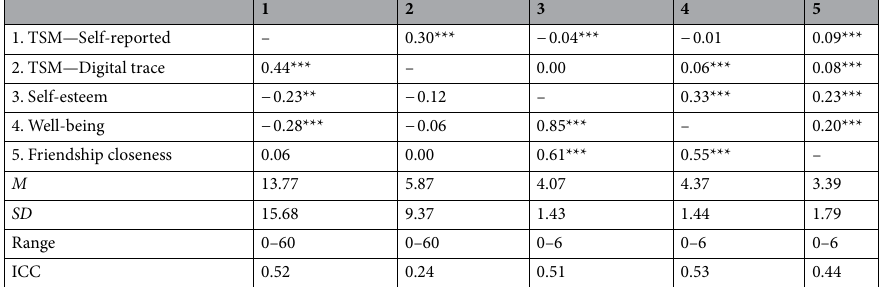
Table 1. Descriptive statistics and between-person, within-person, and intraclass correlations for all study variables. TSM = Time spent on social media. Mean scores for TSM reflect the average number of minutes spent of TSM in the hour previous to the ESM assessments. Correlations below the diagonal line represent between-person correlations, correlations above the diagonal line represent within-person correlations. For the correlations, estimates of TSM according to the self-reported and digital trace measures were log transformed. ICC = intraclass correlation. * p < .05. ** p < .01. *** p < .001.